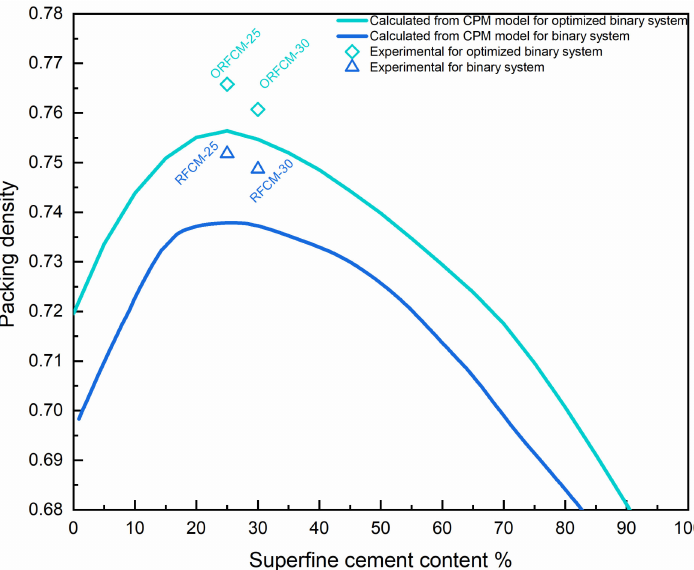
Figure 13. Packing density was calculated from the compressive packing model (CPM) model and MWD)